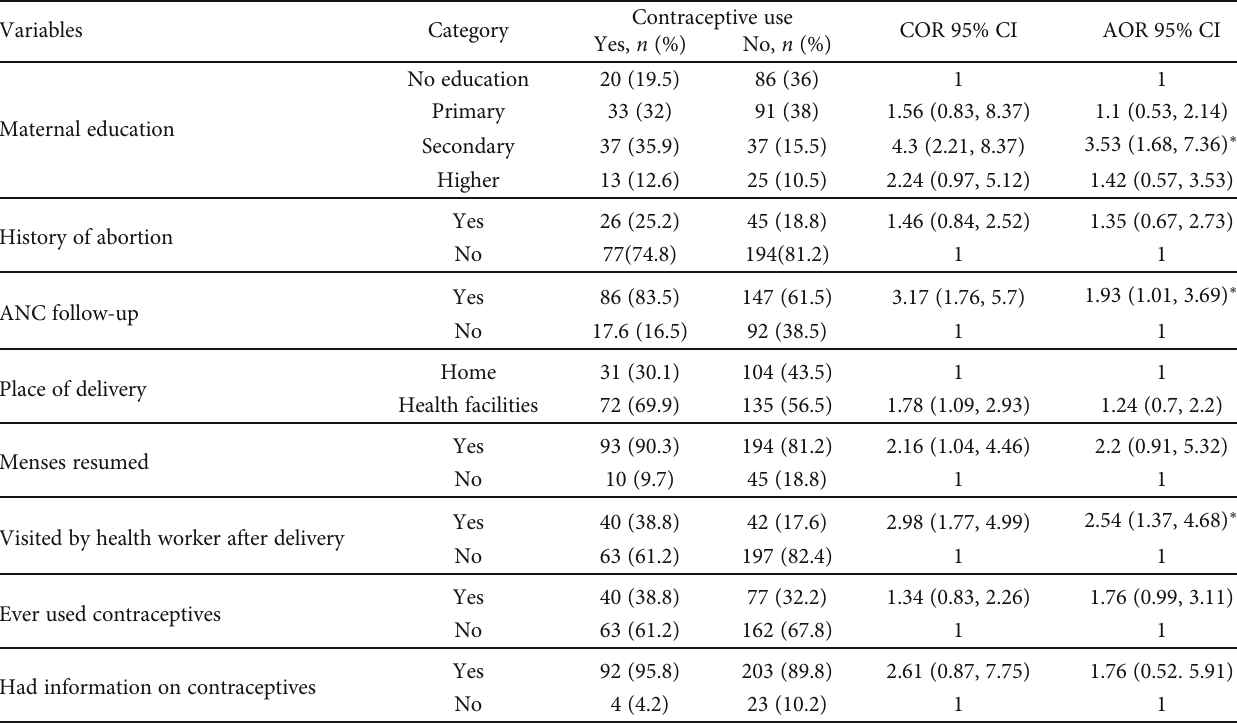
Table 4: Binary and multivariable logistic regression analysis showing factors associated with contraceptive use among study participants in Dubti town, pastoral community, Afar region, Northeast Ethiopia, May 2018.